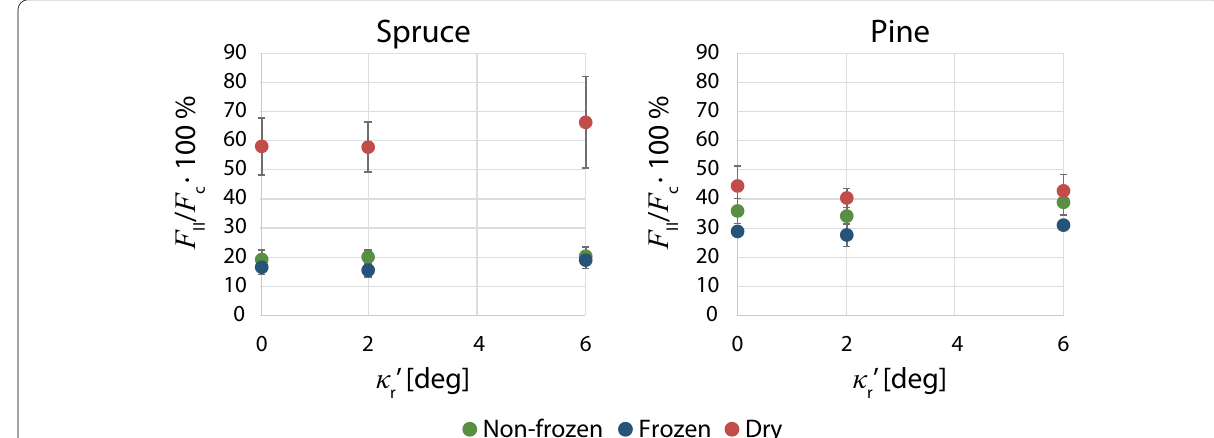
Fig. 12 The Zone II force contribution to the cutting force for with varying minor cutting edge angles ( κ ′ r )